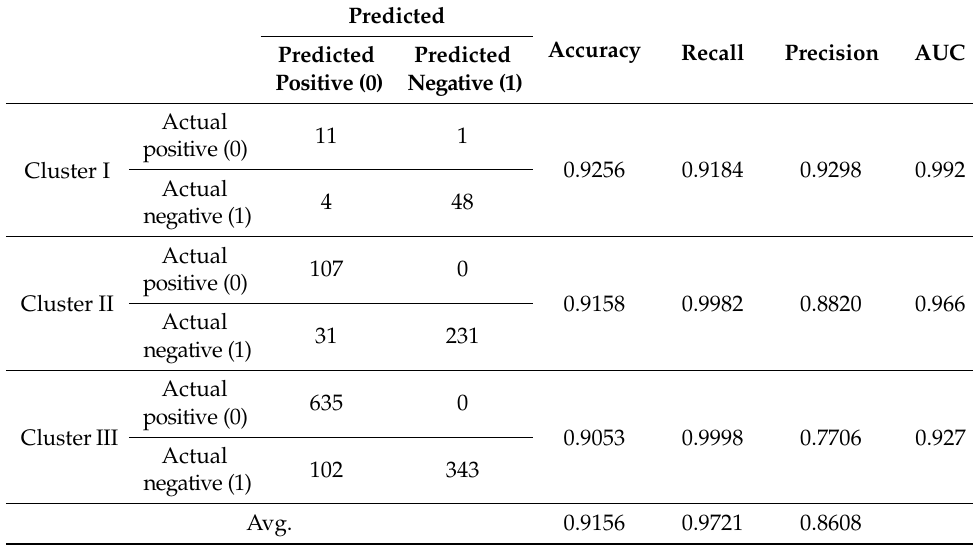
Table 7. SVM confusion matrix after segmentation.